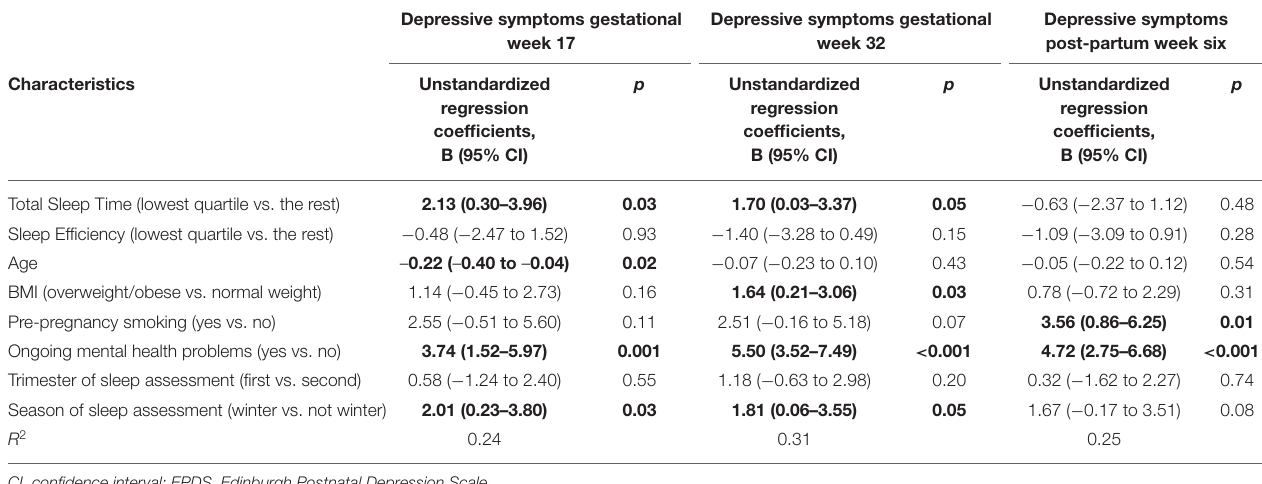
TABLE 2 | Multiple linear regression analyses of the association between objectively assessed sleep parameters and depressive symptoms on the EPDS at gestational weeks 17, 32 and 6 weeks post-partum adjusting for age, BMI at first antenatal visit, pre-pregnancy smoking, ongoing mental health problems at first antenatal visit, trimester at sleep assessment and season at sleep assessment.